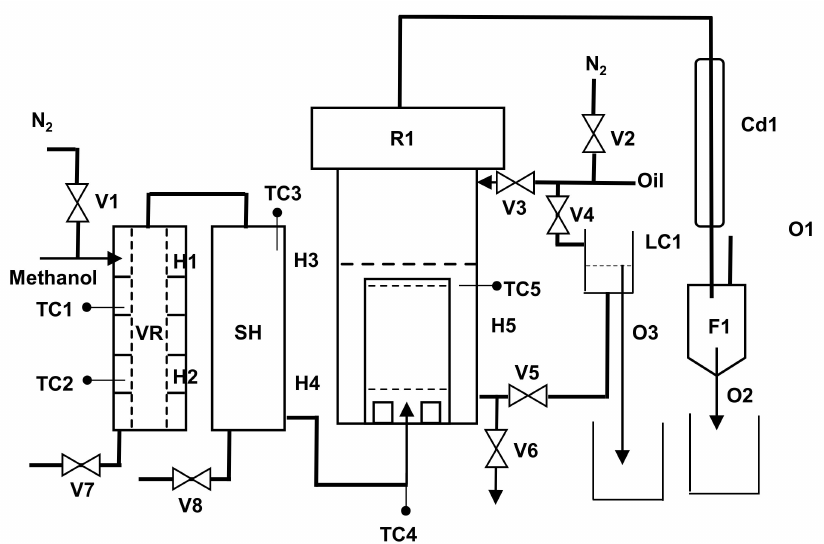
Figure 31. Continuous flow bubble column reactor. Vaporizer (VR); superheater (SH); bubble column reactor (R1); level controller (LC1); condenser (Cd1); glass container for sample collector (F1); valves (V1–V8); electrical heaters (H1–H5); temperature controllers (TC1–TC5); pipe on the top of F1